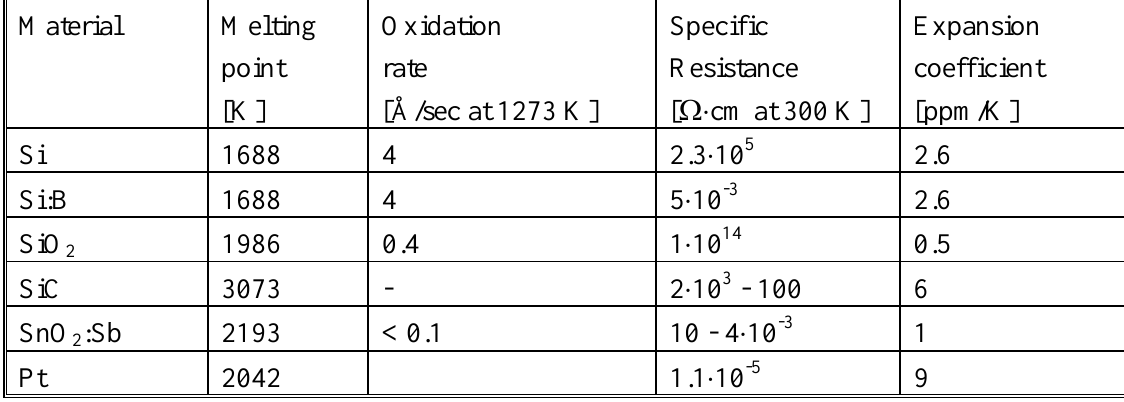
Table 1. Properties of materials used for the emitter design [21-24,26]. Material